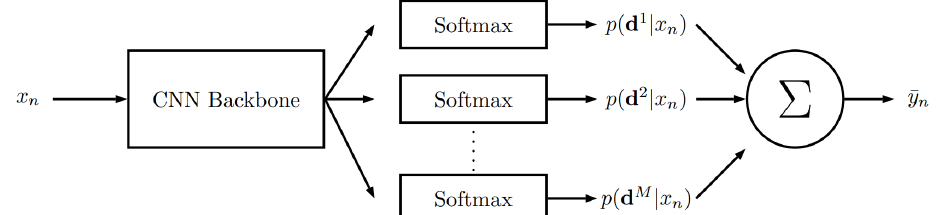
Figure 9. Overview of the RvC-based pose estimation method [6]. p ( d M | x n ) depicts the softmax layer outputs per class D m for an input x n . The outputs are being combined using an ensemble average to obtain a final pose